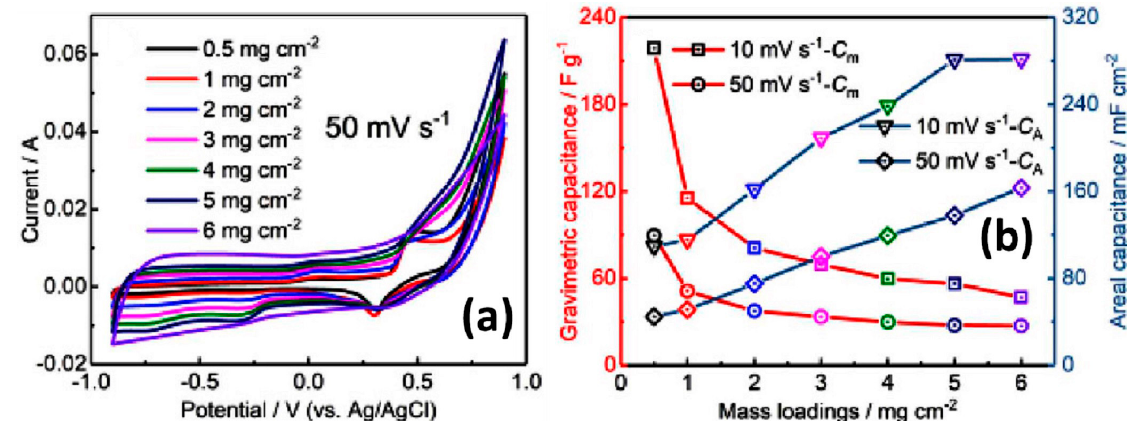
Figure 19. CV curves of CNT@G with different mass loadings at 50 mV/s ( a ) and calculated capacitance of the CNT@G electrode on Ni foam as a function of mass loading ( b ) (Reproduced with permission of [46]. Copyright Elsevier, 2019).